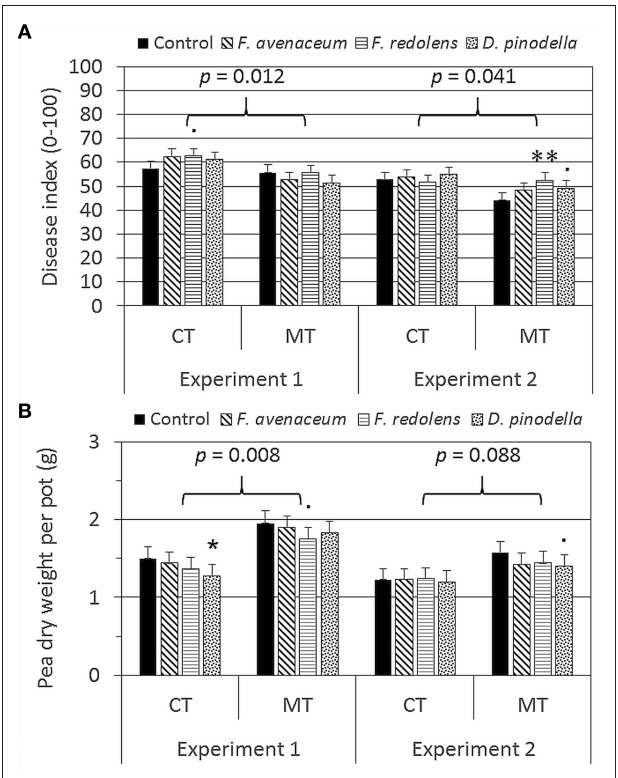
FIGURE 2 | Means and standard errors of pea disease index (A) and dry weight (B) in soils managed with plough tillage without organic mulch (CT) and minimum tillage with organic mulch application to potatoes (MT) (df = 6) after inoculation with three pathogenic fungi compared to the Control ( F. avenaceum, Fusarium avenaceum; F. redolens, Fusarium redolens, D. pinodella, Didymella pinodella , Control, non-inoculated natural soil) (df = 197). Effects were separated for experiment 1 (during grass-clover cropping) and experiment 2 (after potato harvest). Asterisks ( p < 0.05*, p < 0.01**) and dots ( p < 0.1) indicate significant differences of inoculated treatments from the control (linear mixed effects models and estimated marginal means).